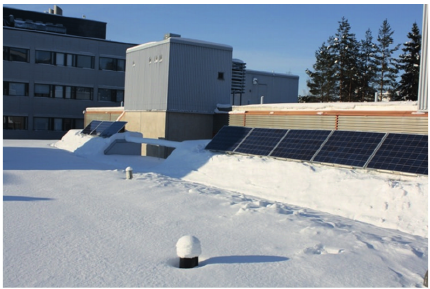
Figure 1: Example of partial shading of a PV string due to a building structure on a sunny day during spring